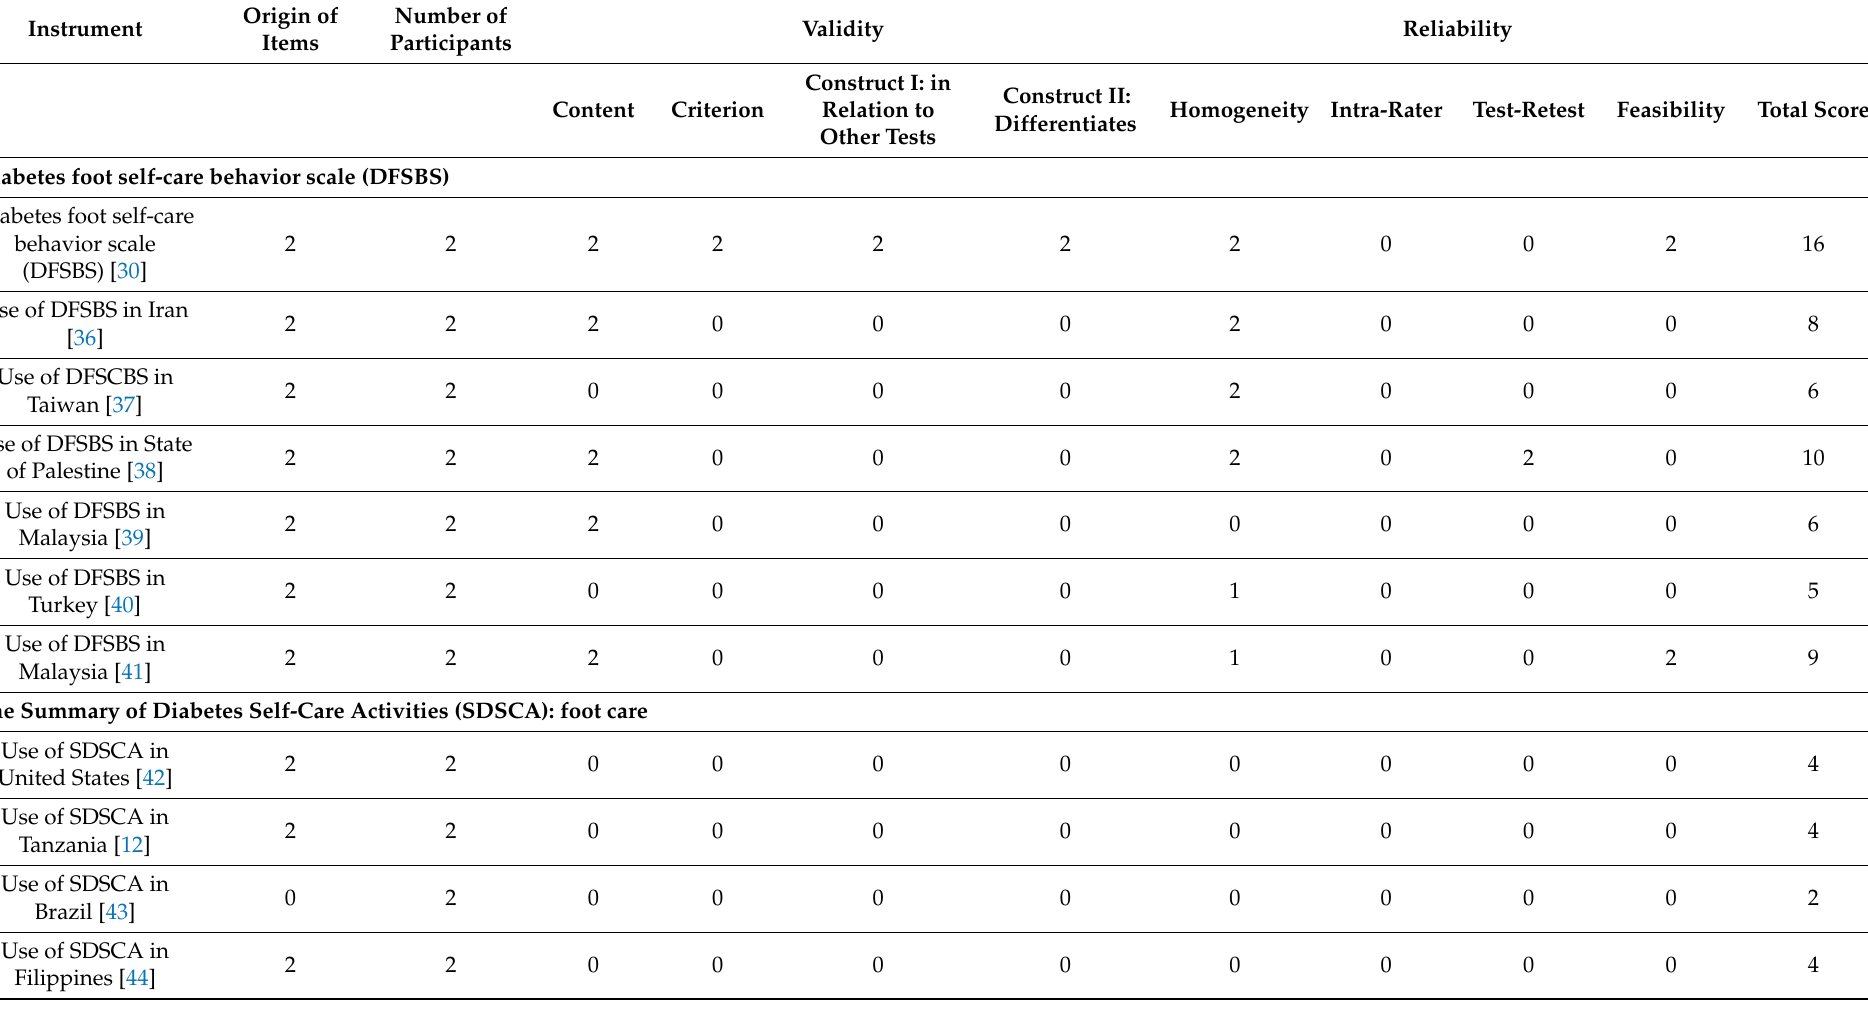
Table 2. Psychometric evidence of six instruments measuring foot self-care, analysed against the criteria proposed by Zwakhalen and colleagues